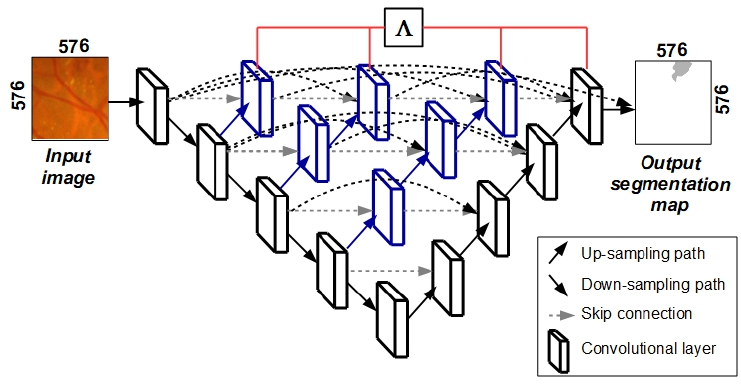
Figure 7. The architecture of the U-Net++ segmentation model.